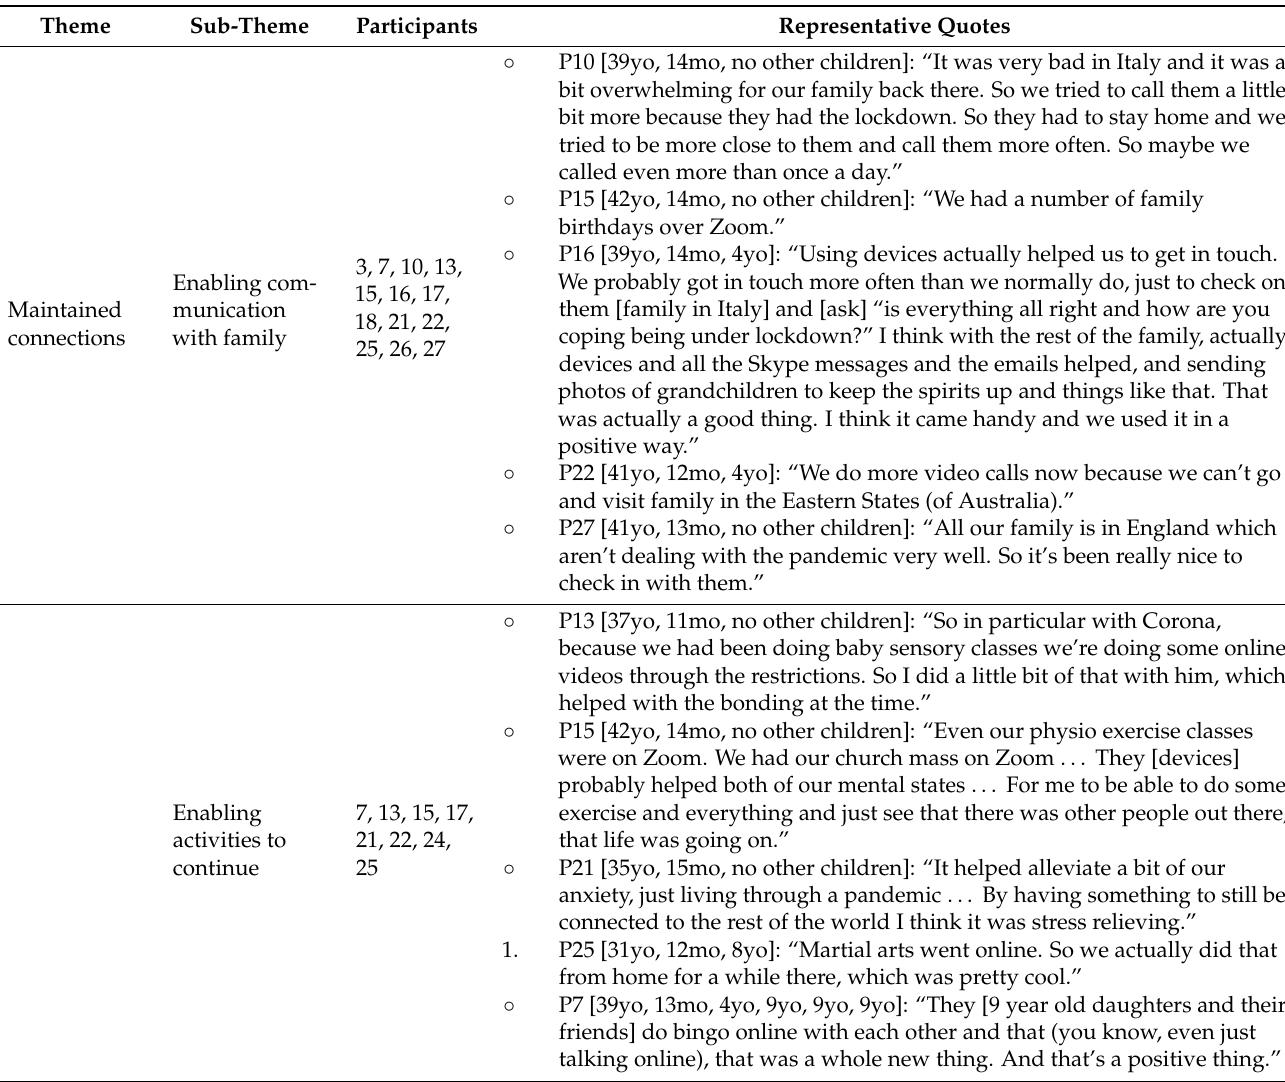
Table 3. Role of mobile touch screen device use during